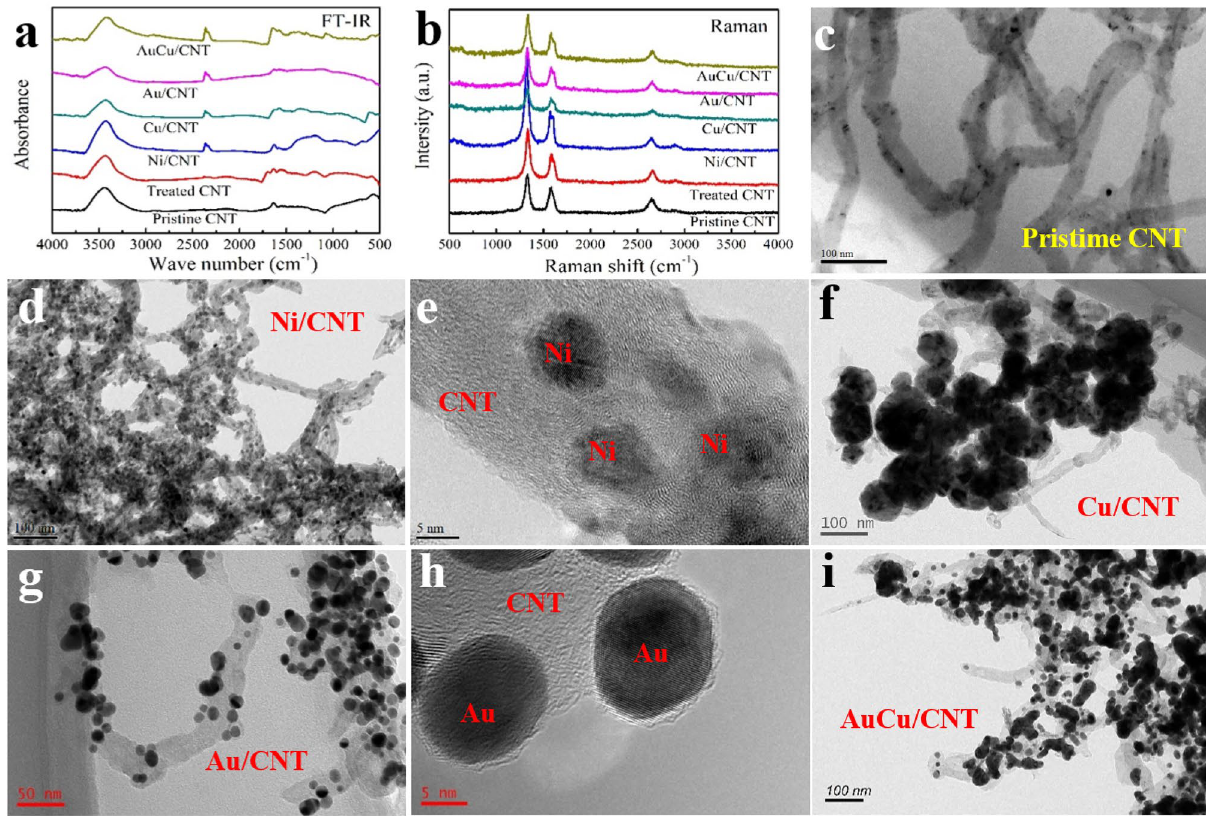
Figure 2. ( a ) FT-IR results of pristine CNT, purified CNT, Ni/CNT, Cu/CNT, Au/CNT and AuCu/CNT. ( b ) Raman results of pristine CNT, purified CNT, Ni/CNT, Cu/CNT, Au/CNT and AuCu/CNT. Morphology of ( c ) Purified CNT, ( d , e ) Ni/CNT, ( f ) Cu/CNT, ( g , h ) Au/CNT, ( i )